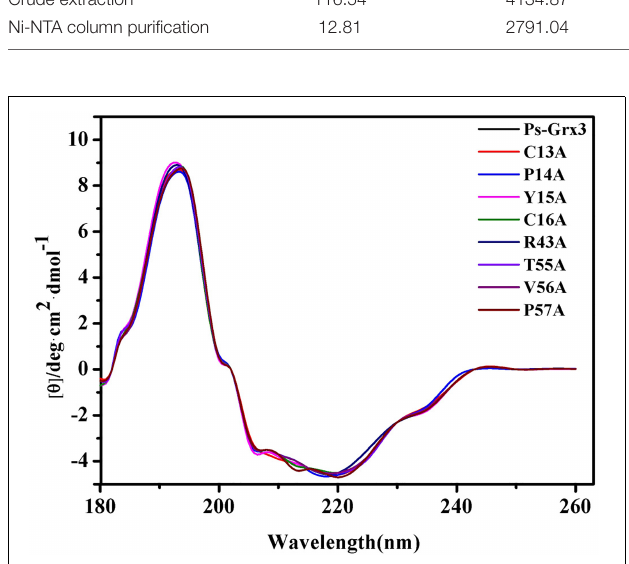
FIGURE 5 | Far-ultraviolet (UV) circular dichroism (CD) spectra from 180 to 260 nm of Ps-Grx3 and its mutant forms.